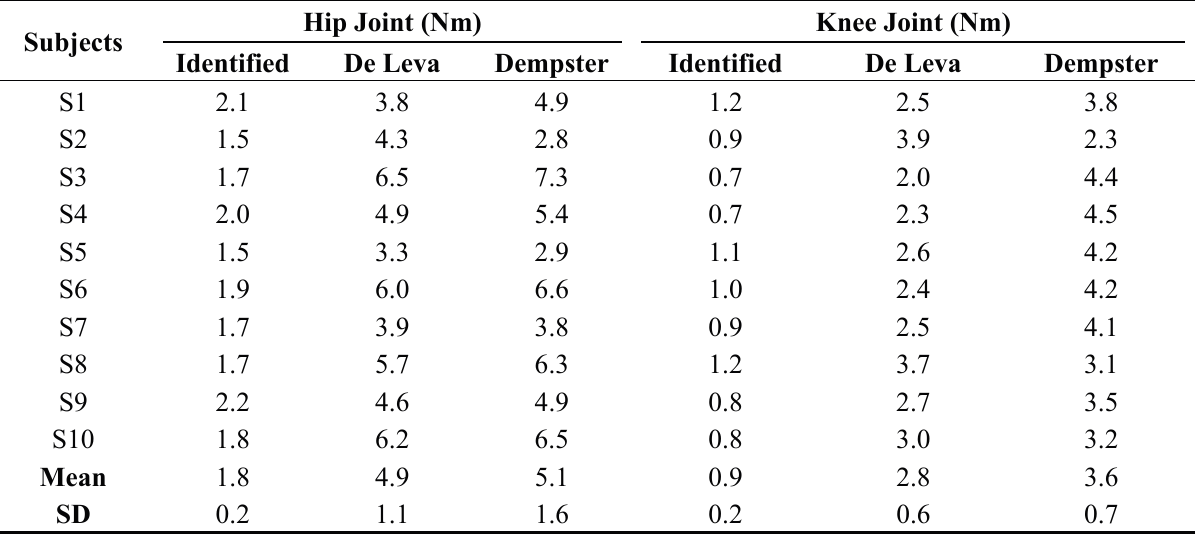
Table 5. RMS error for the estimation of the measured torque in passive-mode gait training.